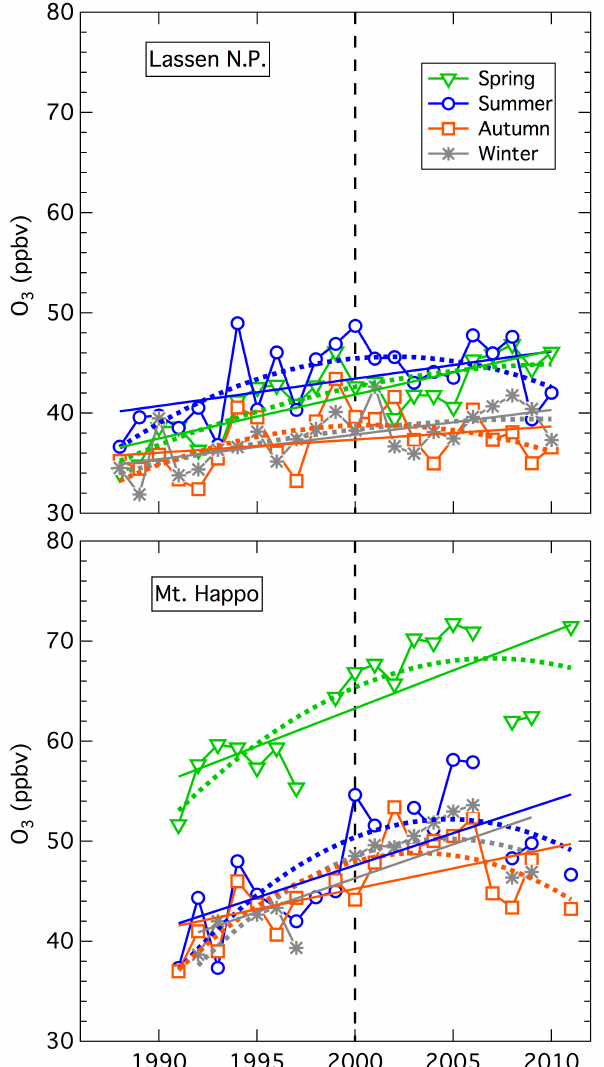
Fig. 4. Seasonal O 3 averages measured at high elevation ( ≈ 1.9km) sites in western North America at Lassen NP and in Japan at Mt. Happo. Lines indicate linear and quadratic regressions for the com- plete data sets in the same format as Fig.